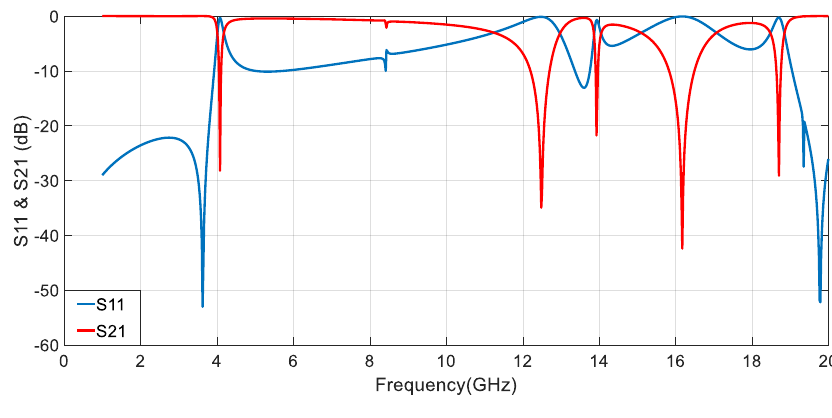
Figure 12. Circular SRR designed in HFSS.